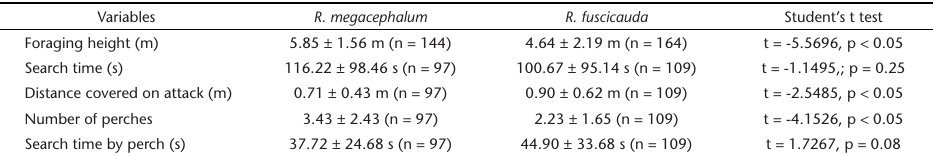
Table 1. Result of the Student’s t test for continuous variables of the foraging behavior of Ramphotrigon megacephalum and R. fuscicauda